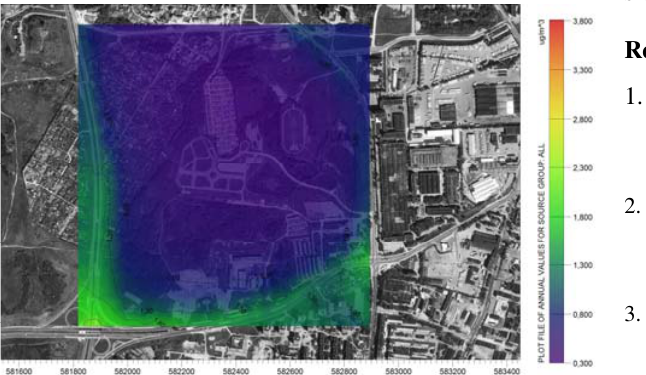
Fig 8 . Graphic view of pollutant dispersion modeling (SO 2